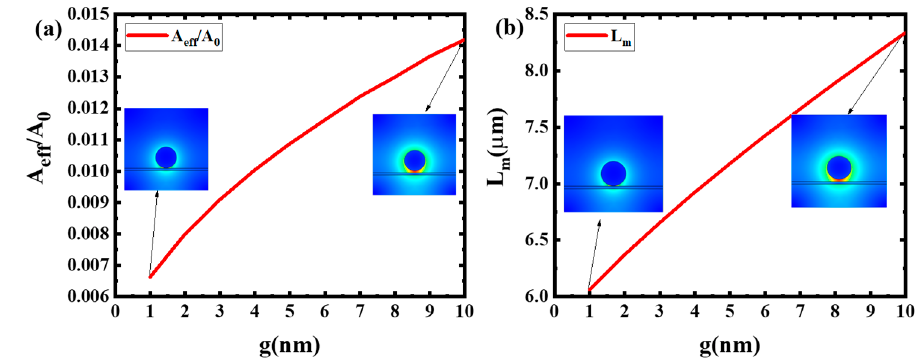
Figure 4. Dependence of normalized effective mode area and propagation length on the gap g at R = 50 nm: ( a ) A eff /A 0 ( b ) L m.